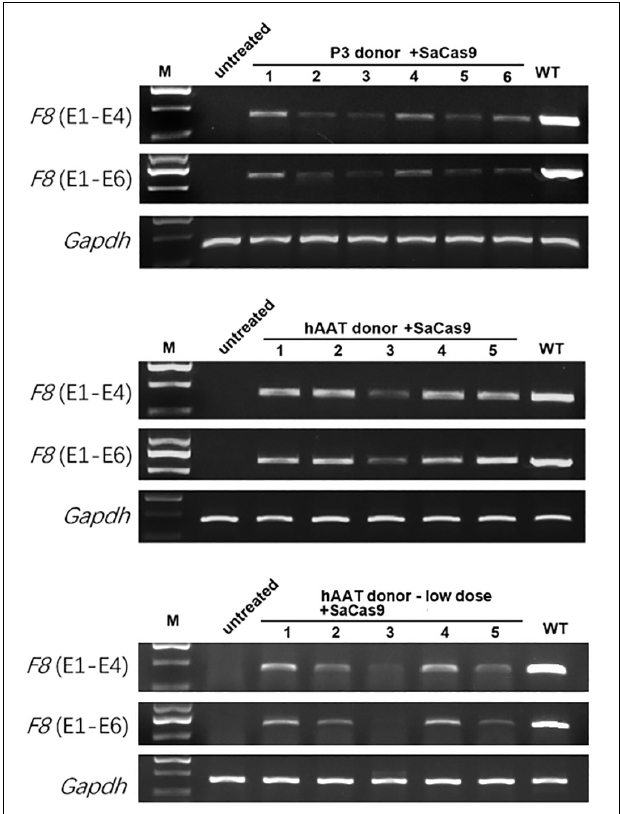
FIGURE 5 | RT-PCR analysis of the liver tissues 1 month after treatment. Gapdh was used as a loading control.